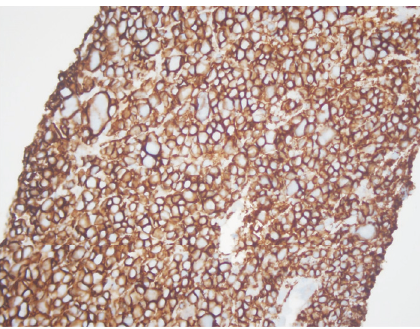
Figure 5: Liver biopsy CD138 marker confirming neoplastic extramedullary plasma cell infiltration from multiple myeloma.